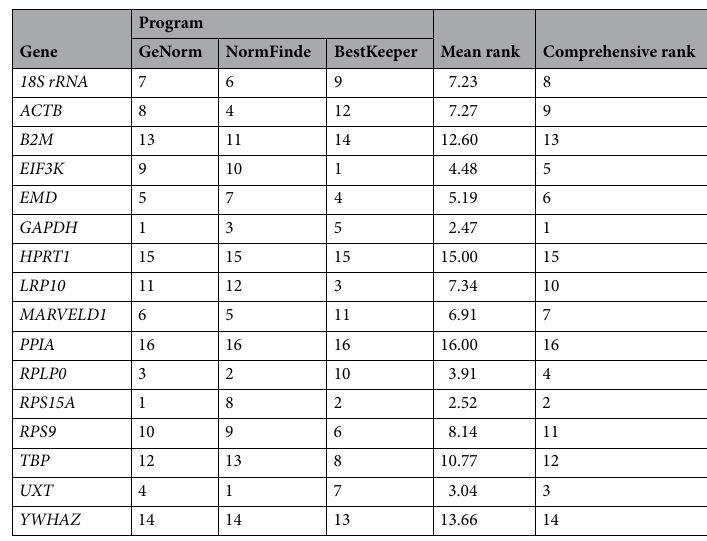
Table 3. Stability classes of candidate reference genes in the proliferation of bovine SMSCs analyzed by a combination of the three algorithms.